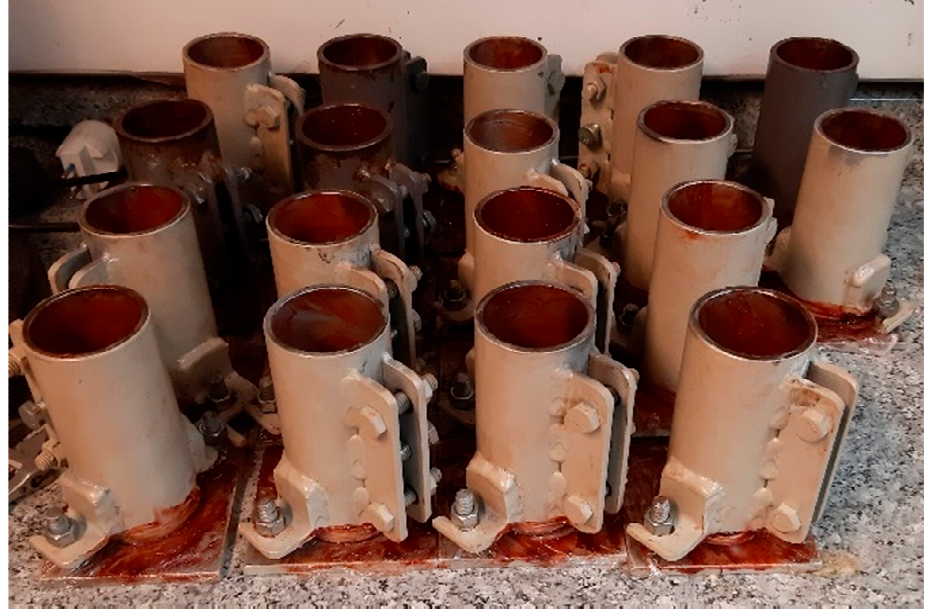
Figure 5. Prepared steel